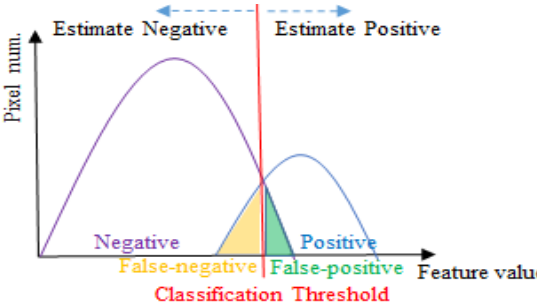
Figure 5. The feature distribution and threshold (classifier) for a binary classification process.